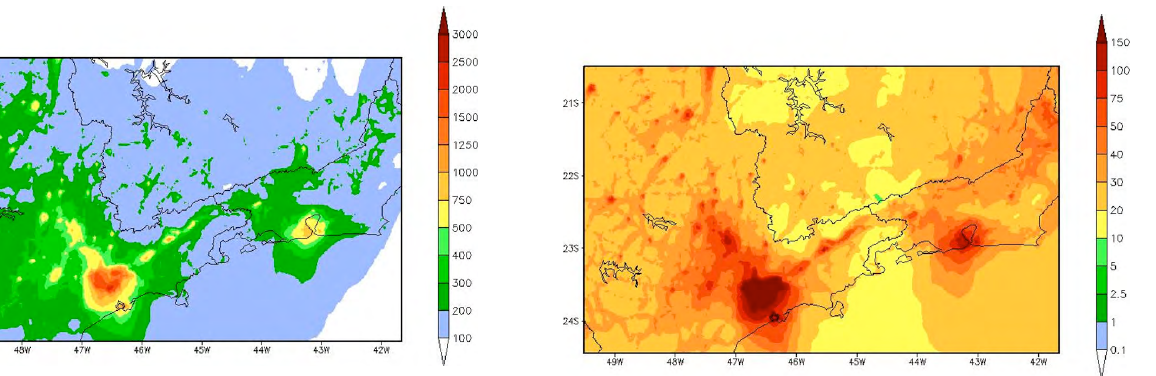
Fig. 9. Monthly average spatial distribution of NO x mixing ratio (ppbv) at 09:00 LT from the model.